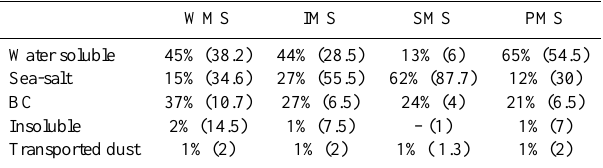
Table 2. The relative contribution of various aerosol species to the composite aerosol optical depth at 500nm and relative contri- bution of various chemical species to the composite aerosol mass (in